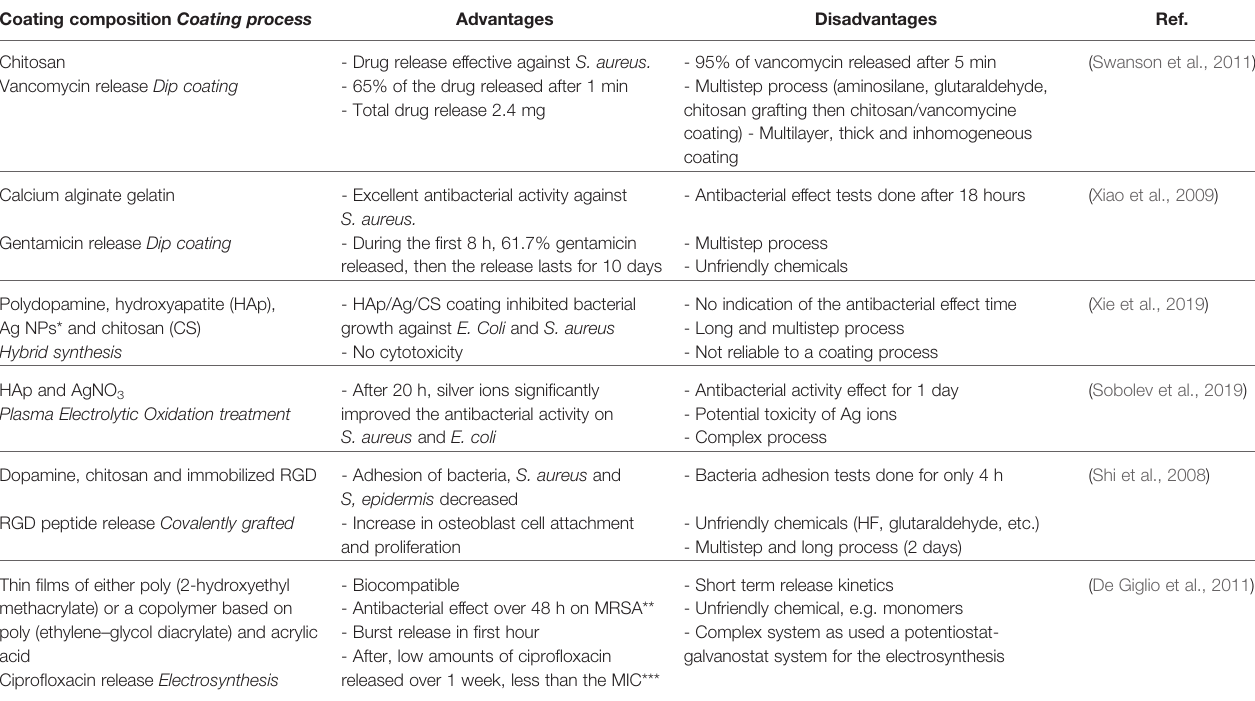
TABLE 1 | Advantages and disadvantages of some coatings on Ti and Ti alloys, reported in the